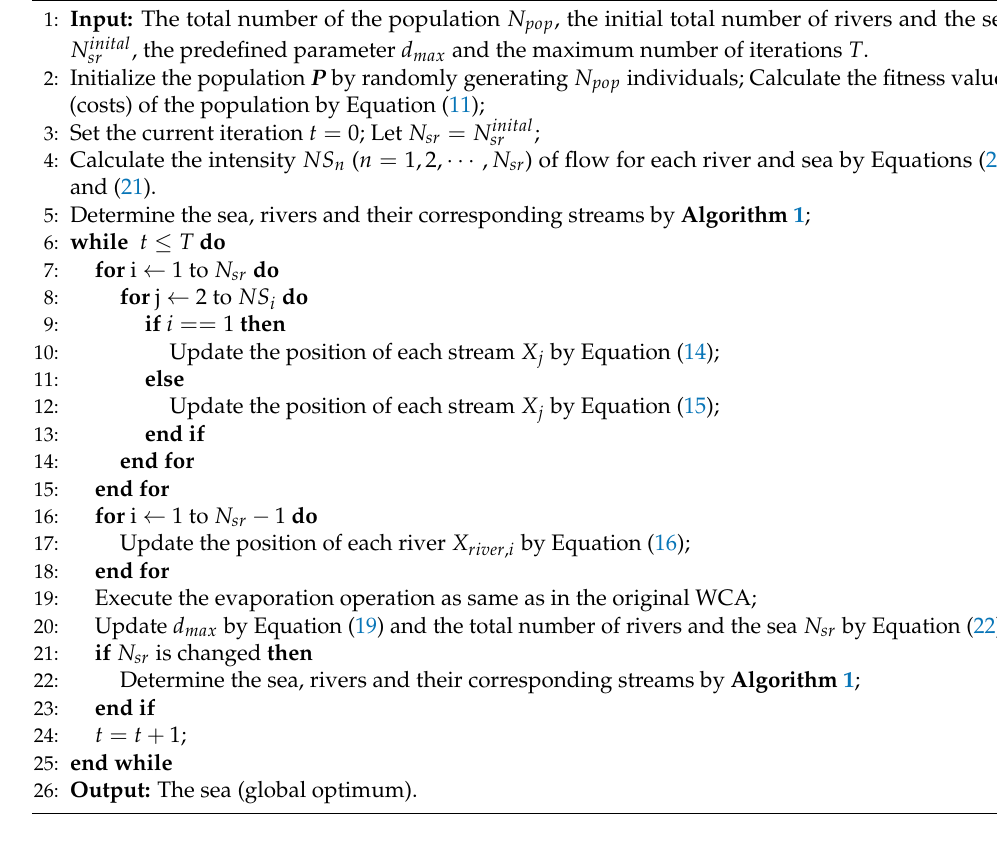
Algorithm 2 The framework of the